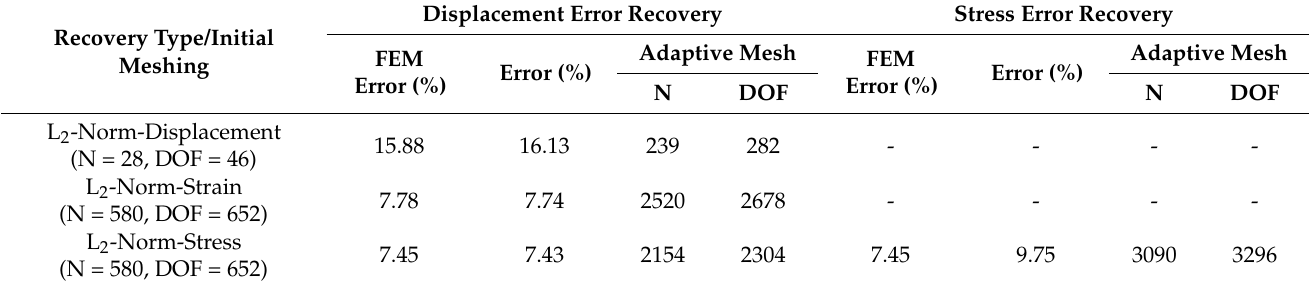
Table 6. Global errors (FEM and processed, L 2 -Norm) and number of element (N) with DOF of adaptively refined meshes (considering displacement and stress recovery-based analysis (linear triangle, 3% target error).